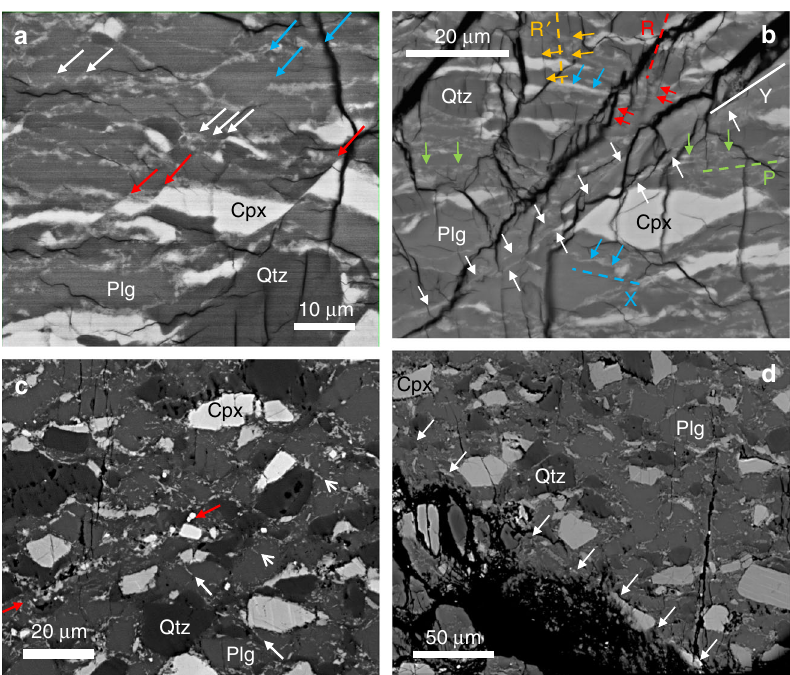
Fig. 8 Organization of fault zones in samples deformed at 1073 K. a , b D1996 (G sample). a Wide-spread intra-grain ruptures. Red, blue, and white arrows mark intra-grain ruptures in Cpx, Plg, and Qtz, respectively. These ruptures are connected by thin NRBs to form larger, complex shear zones. b Formation of larger fault zones. Shear and ruptures developed along several directions, which can be interpreted as Riedel shears 52 . Y shears (solid white line; parallel to the main shear zone) dominate the microstructure, characterized by long and continuous NRBs cutting through multiple grains (delineated by white arrows). R and P shears are ~±30° from the Y shears (light green and red dashed lines and arrows). R ′ and X shears are ~±60° from the Y shears (yellow and blue dashed lines and arrows). R and R ′ shears are less well developed and commonly associated with microfractures. c , d D1787 (EG sample). c Wide- spread eclogitization reaction along grain boundaries and within Plg grains. Numerous reaction bands terminate within the Plg grains, along the NW-SE (white arrows). These reaction bands typically initiate from grain-grain contacts, suggesting a stress assisted reaction. Indicated in between the two opposing red arrows is a complex shear zone with multiple subparallel NRBs. Compared to D1996, D1787 contains numerous small voids along grain boundaries. These voids may be cavities caused by the large volume reduction of the reaction, although we cannot completely rule out the possibility of small grains popping off during polish. d A large shear band consisting of reaction products cutting through multiple grains with different mineralogy (delineated by white arrows that are nearly perpendicular to the